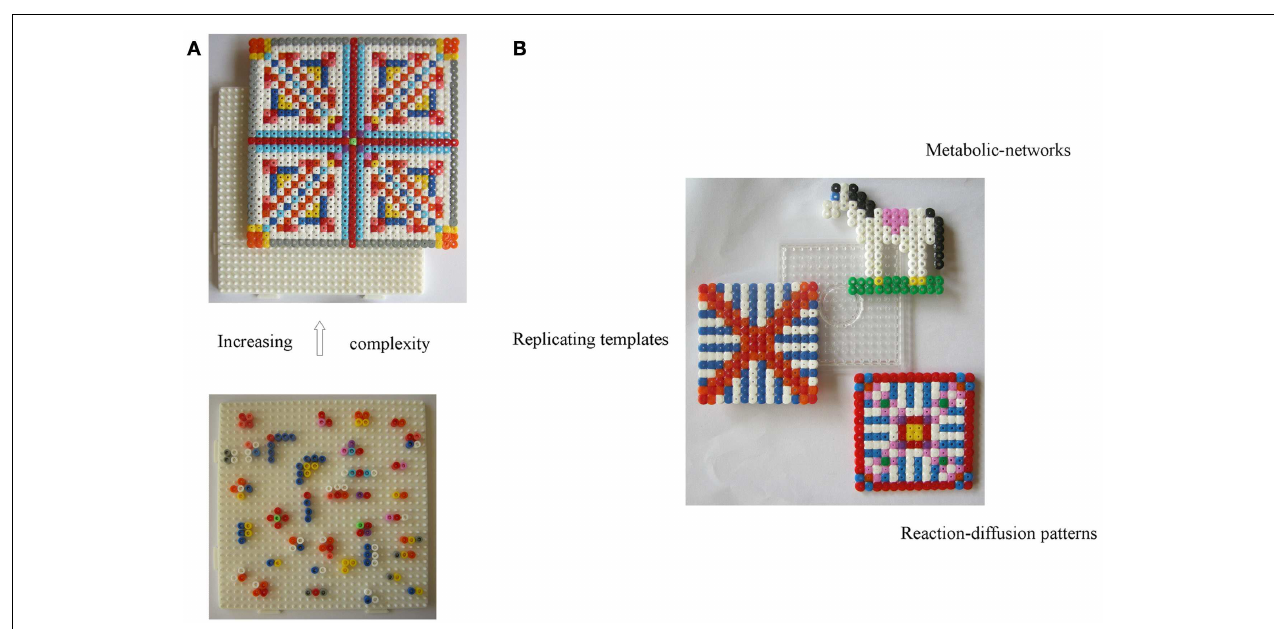
organization which has functionally replaced the original crystal one at level-I. (B) To make this scenario compatible with soft colloidal dynamics and facilitate the “takeover” of level-I by a hierarchy of functioning modules, we suggest a reversible field-stabilized scaffold with a modular organization – represented by a transparent pin board. A stable inorganic scaffold is also compatible with the simultaneous emergence of (and replacement by) different types of organic spatio-temporal correlations, and as each of these would be dependent on the scaffold, any external tinkering with the latter’s degrees of freedom (d.o.f.s), would also impact the different organic networks and facilitate their mutual coupling (see